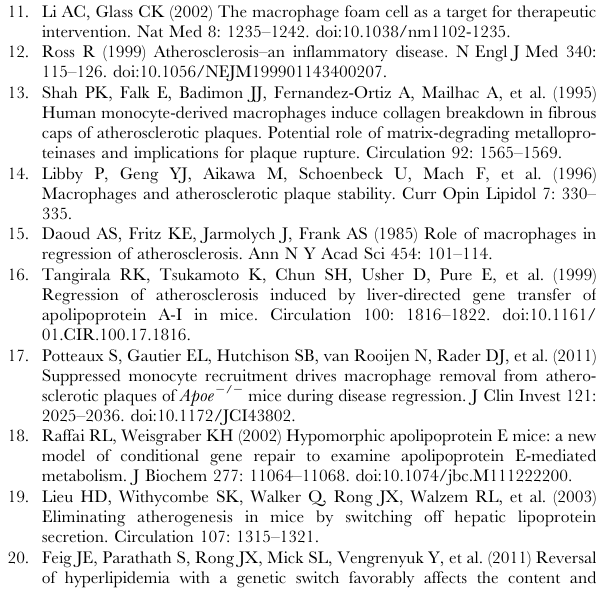
(location relative to nearest gene; ‘‘nearGene-3’’ indicates that the SNP is located downstream of the 3 9 end of a gene). Table S8 Sources of epigenomic and transcription factor binding site ChIP-seq data used for features and training (respectively) for the computational model for mapping cis - regulatory regions Columns are as follows: (A) Transcriptional regulator or chromatin mark; (B) Proposed function; (C) Source; (D) Accession number of the ChIP-seq data set (where applicable). Table S9 Statistically overrepresented motifs within up- or down-regulated genes in the Reversa model. Results for the sets of upregulated and downregulated genes are presented in separate blocks of rows, each labeled ‘‘for upregulated genes’’ and ‘‘for downregulated genes’’ respectively. The results of a motif scan of the upregulated genes using TCF/LEF family motifs from TRANSFAC 2013 are reported in a third block of rows, marked ‘‘TCF/LEF Scan of upregulated genes with TRANSFAC 2013’’. Columns are as follows: (A) Motif ID; (B) Motif description (note: ‘‘HS’’ indicates a half-site for a bipartite binding site sequence); (C) Consensus sequence pattern; (D) Binding site match frequency enrichment ratio in the differentially expressed gene set vs. the frequency expected by chance among macrophage-expressed genes; (E) P value for the binomial test on the frequency of matches; binding site frequency enrichment ratio in differentially expressed genes in the transplant regression model. Table S10 Numbers of genes with transcription factor binding site sequence matches of the indicated types, within their promoter regions. Results for the sets of upregulated and downregulated genes are presented in separate sections labeled ‘‘for upregulated genes’’ and ‘‘for downregulated genes’’ respectively. Columns are: (A) motif identifier; (B) motif description; (C) number of genes possessing a match for the motif within their promoter regions; (D) fraction of genes; (E) number of cytoskeleton-related genes (based on GO annotation) possessing a match for the motif within their promoter regions.